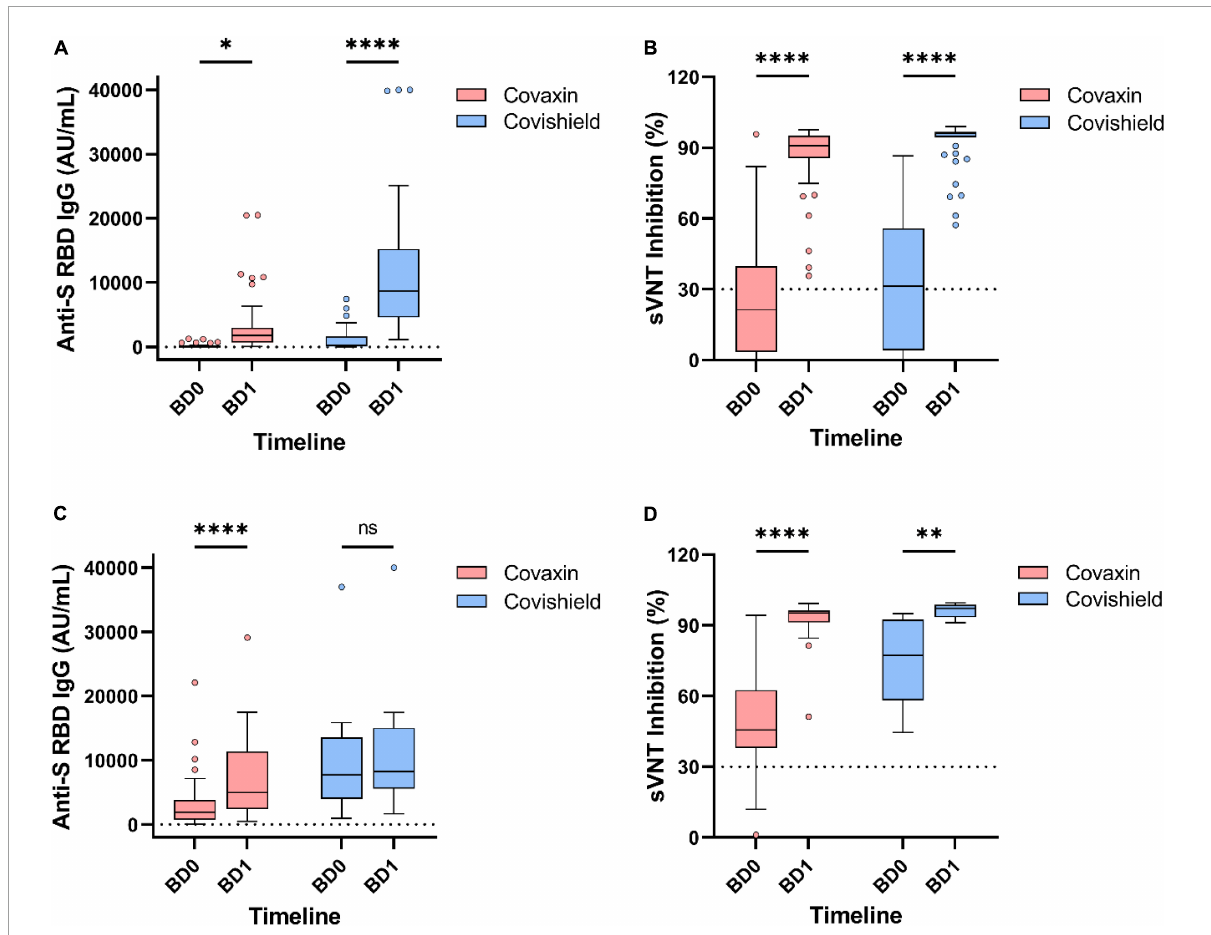
FIGURE5 Antibody responses by different vaccines after 1 month of booster dose. Level of anti-spike RBD IgG antibody and percentage inhibition of neutralizing antibodies in booster recipients without any prior breakthrough infection (A,B) and with prior breakthrough infection (C,D) . ns, non-significant; ∗ p < 0.05; ∗∗ p < 0.01; ∗∗∗∗ p < 0.0001. Tukey method was used to plot whiskers. BD0, before booster dose; BD1, 1 month after booster